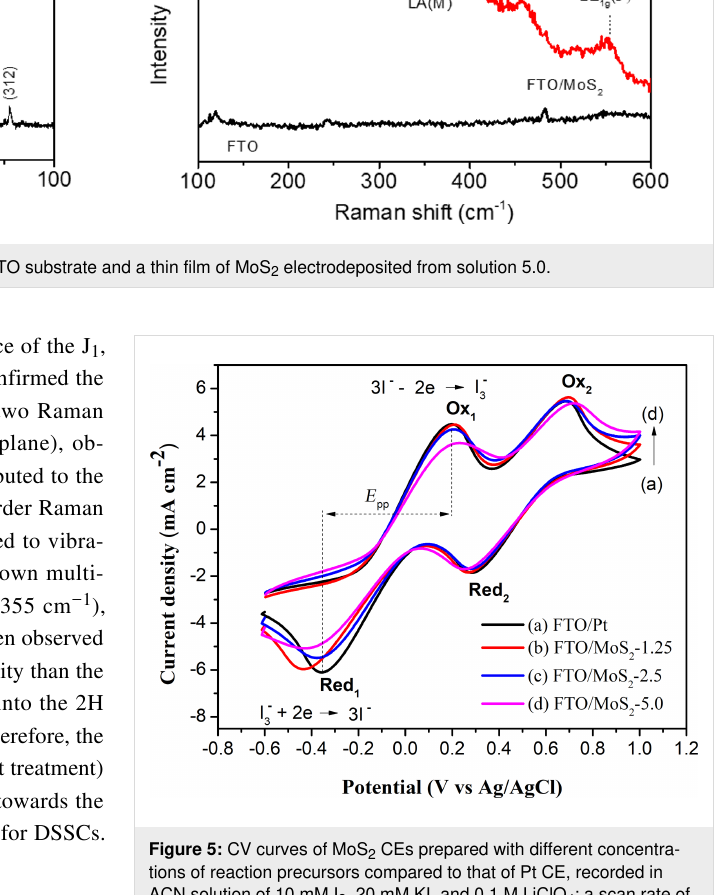
Figure 5: CV curves of MoS 2 CEs prepared with different concentra- tions of reaction precursors compared to that of Pt CE, recorded in ACN solution of 10 mM I 2 , 20 mM KI, and 0.1 M LiClO 4 ; a scan rate of 100 mV·s − 1 was